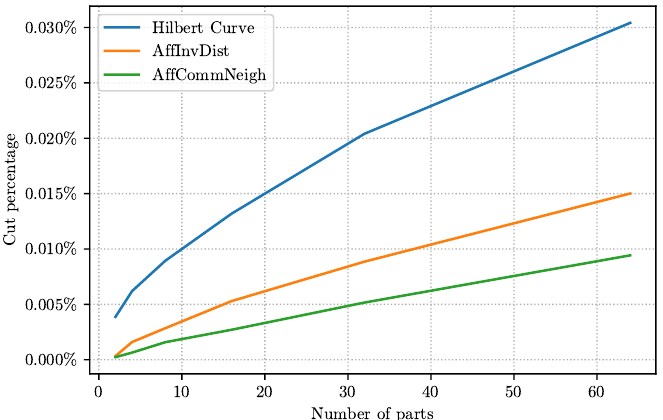
Figure 5. Comparison of the (fully balanced) cut size for Hilbert , AffInvDist and AffCommNeigh on World-roads